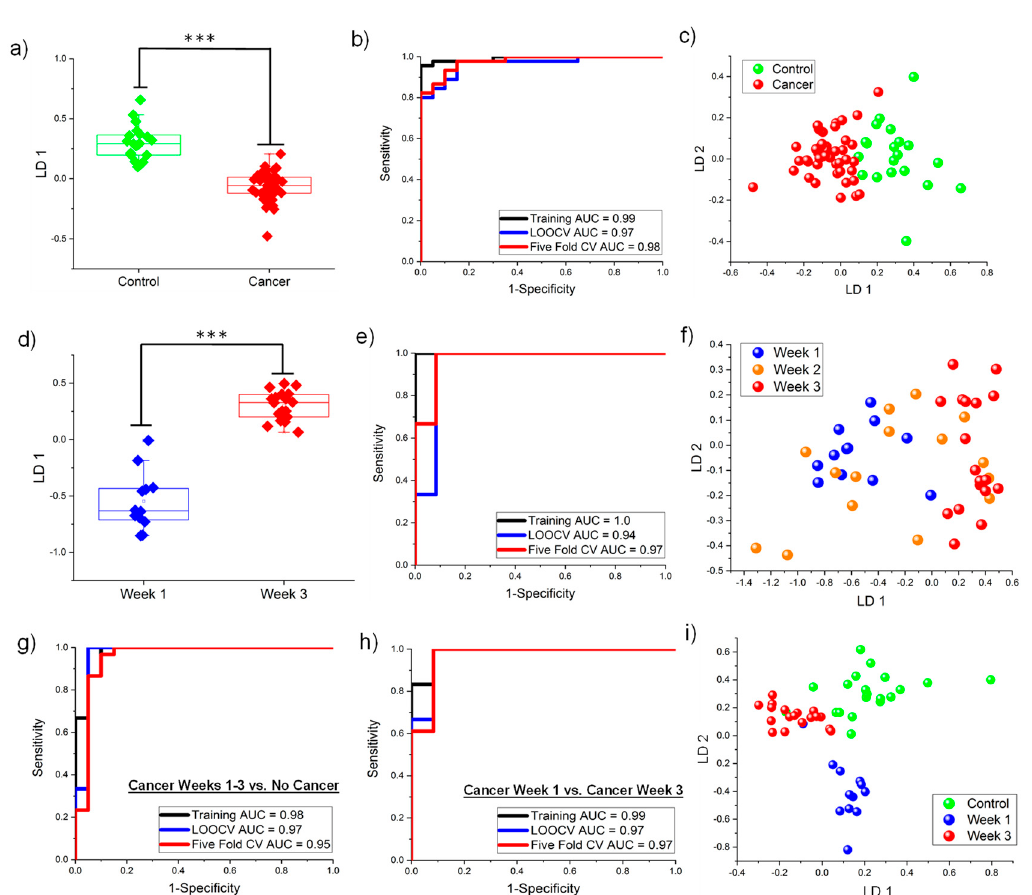
Figure 4. ( a – c ) First LDA Model distinguishes all Cancer (Weeks 1–3) from Control with high accuracy using five VOCs showing results in ( a ) one dimension, ( b ) the receiver operator characteristic (ROC), and ( c ) First LDA model in two dimensions. ( d – f ) Second LDA Model distinguishes Cancer Week 1 from Cancer Week 3 with high accuracy showing results using five VOCs in ( d ) one dimension, ( e ) the ROC for Week 1 vs. Week 3, and ( f ) Second LDA model in two dimensions. Week 2 samples shown in ( f ) not included in ( d ) LD1 or ( e ) ROC analysis. ( g – i ) Third LDA Model separates Cancer Week 1, Cancer Week 3 and Control with high accuracy. The ROC curves are shown for ( g ) Cancer Weeks 1 and 3 vs. Control and ( h ) the Cancer Week 1 vs. Week 3. ( i ) The third LDA model in two dimensions. *** p < 0.001.